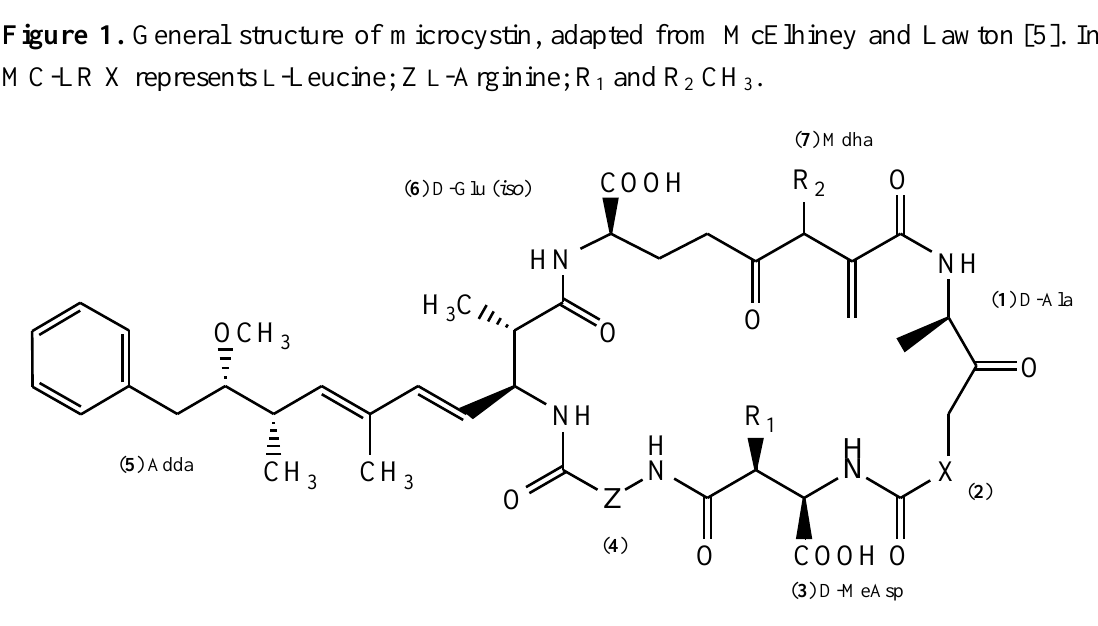
Figure 1. General structure of microcystin, adapted from McElhiney and Lawton [5]. In MC-LR X represents L -Leucine; Z L -Arginine; R